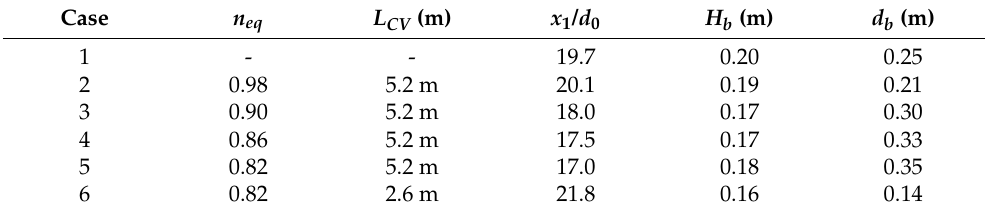
Figure 7. Phase ‐ averaged 2DV envelope of the free ‐ surface elevation of waves propagating and Figure 7. Phase-averaged 2DV envelope of the free-surface elevation of waves propagating and breaking for Cases 1 (top) and 2 (bottom). Note that the axes are in scale x 1 / x 3 = 0.1 for clarity of the breaking for Cases 1 ( top ) and 2 ( bottom ). Note that the axes are in scale x 1 / x 3 = 0.1 for clarity of exposition. the exposition. Table 2. Wave breaking streamwise position, height and depth for all simulated